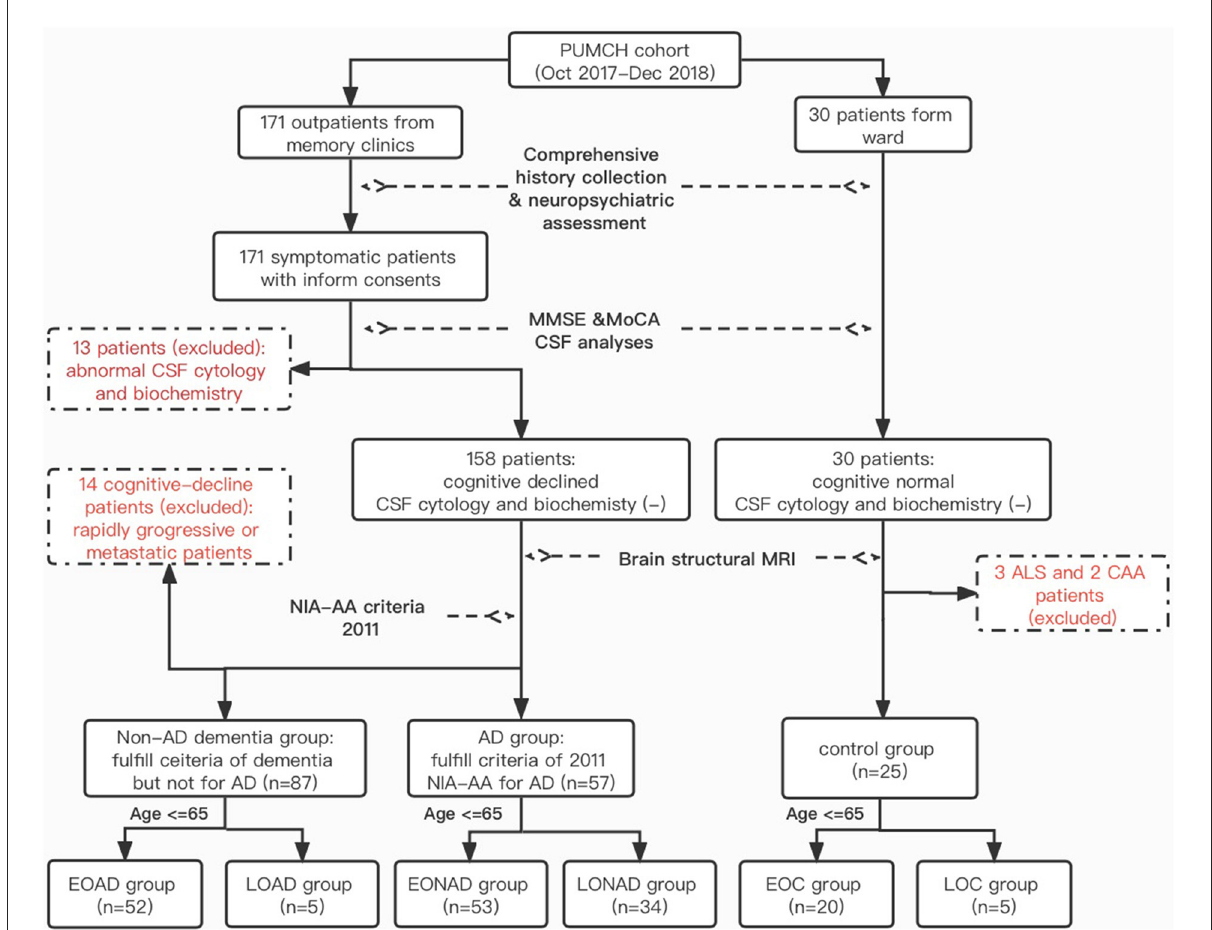
FIGURE1 Inclusion and exclusion criteria. *PUMCH, Peking Union Medical Collage Hospital; NIA-AA, National Institute on Aging and Alzheimer’s Association; MMSE, Mini-Mental State Examination; MoCA, Montreal Cognitive Assessment; EO(LO)AD, early-onset (late-onset) Alzheimer’s disease; EO(LO)NAD, early-onset (later-onset) non-Alzheimer dementia; EO(LO)C, early-onset (late-onset) control; ALS, amyotrophic lateral sclerosis; CAA, cerebral amyloid